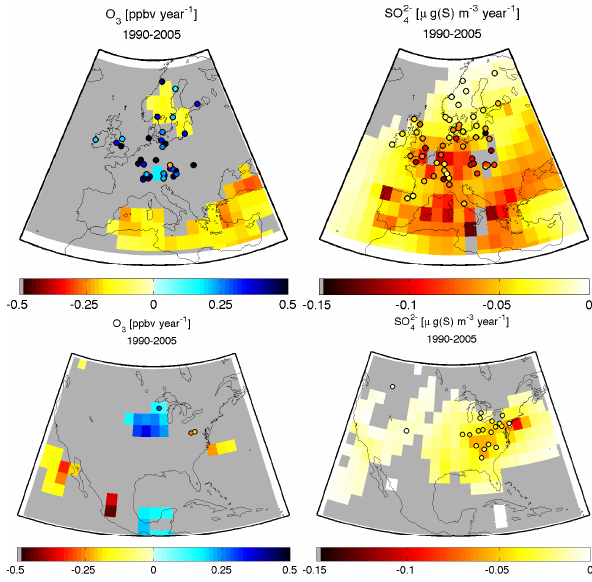
Fig. B3. Annual trends of O 3 and SO 2 − surface concentrations. 4 The trends are calculated as linear fitting of the annual mean sur- face O 3 and SO 2 − anomalies for each grid box of the model simu- 4 lation SREF over Europe and North America. The grid boxes with statistically not significant (p-value > 0.05) trends are displayed in grey. The colored circles represent the observed trends for EMEP and CASTNET measuring stations, over Europe and North Amer- ica, respectively. Only the stations with statistically significant (p- value < 0.05) trends are